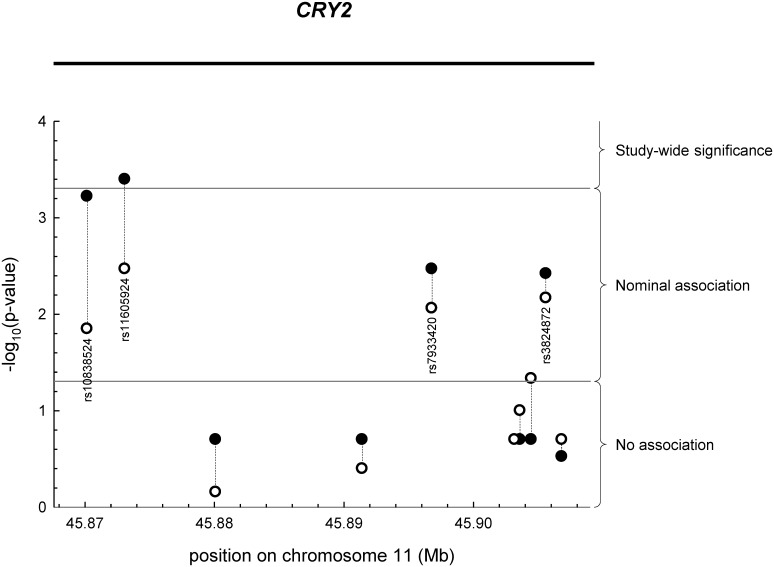
Association of CRY2 SNPs with fasting glucose concentrations (closed circles) and liver fat content (open circles).SNPs were plotted according to their positions in the CRY2 locus on chromosome 11 and their association p-values. Study-wide significance p < 0.0005; nominal association 0.0005 ≤ p < 0.05. SNP—single nucleotide polymorphism.